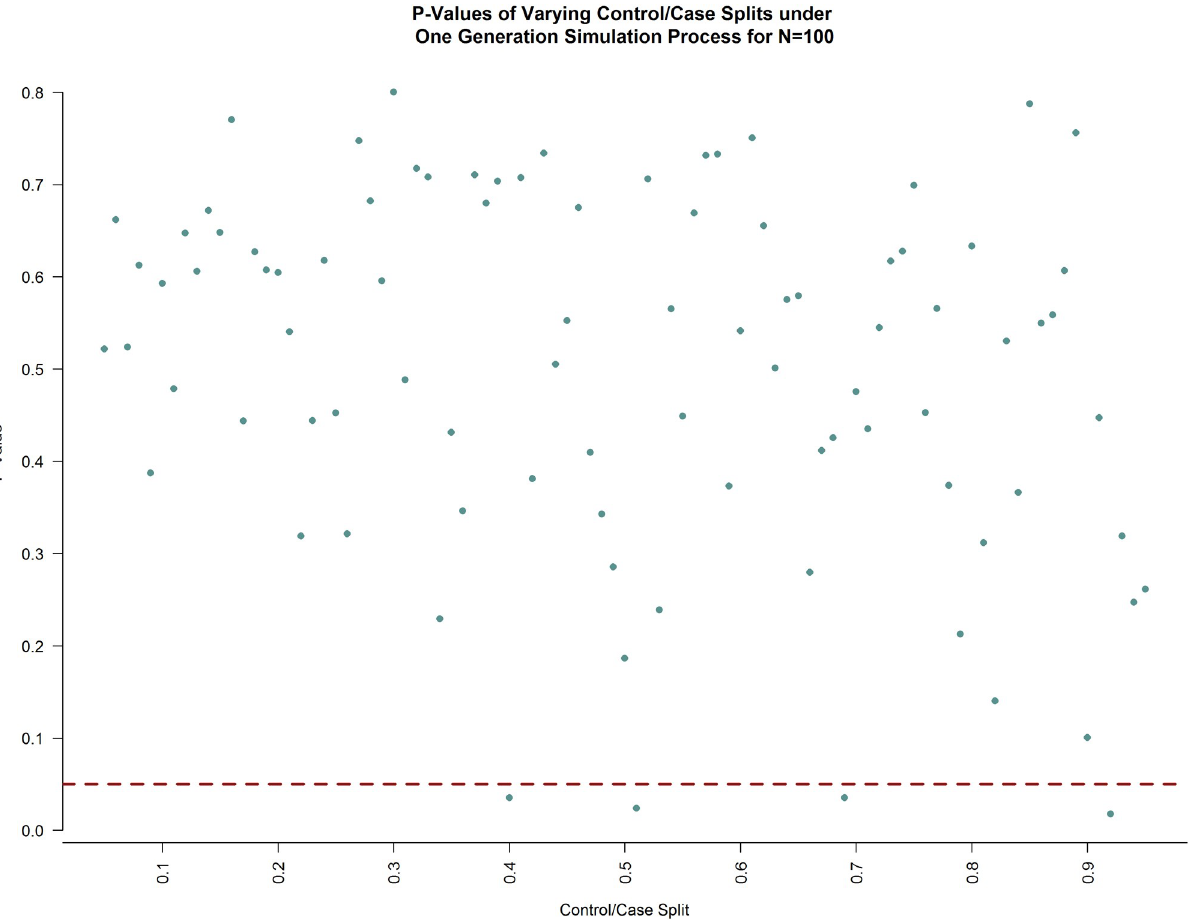
Fig 7. P-values under varying noise population allocations under a one generation simulation process. Allocation of the 100 generated connectivity matrices varied from 5:95 to 95:5, increasing in increments of one. The red dashed line is at the nominal p-value of 0.05. Any point below this red line is a false positive while any point above this red line is a true negative. As can be seen, the false positive rate from this simulation agrees with the Type I error rate previously calculated.